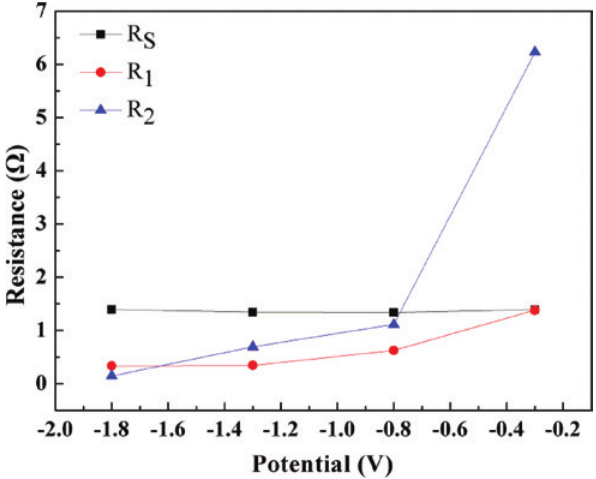
Fig. 4: The fitted parameters obtained for the equivalent